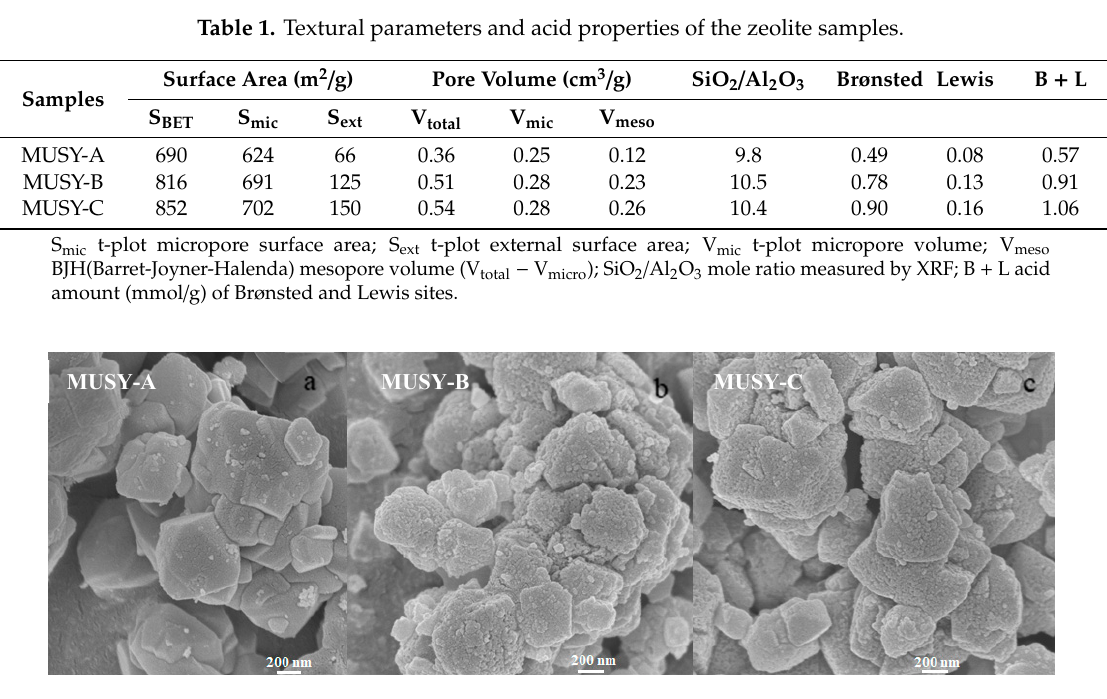
Table 1. Textural parameters and acid properties of the zeolite samples.